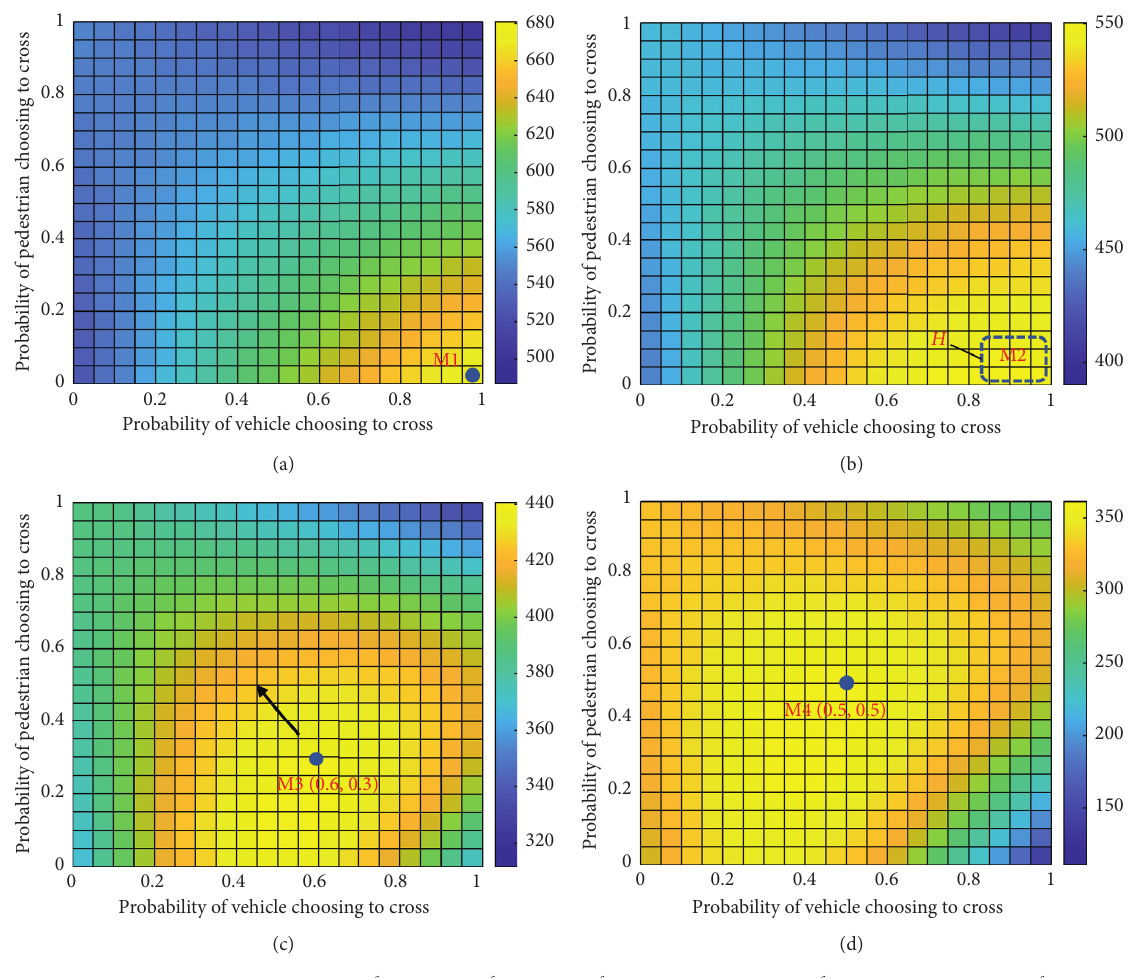
� 500 ( ped/h ) . (c) q f p 1